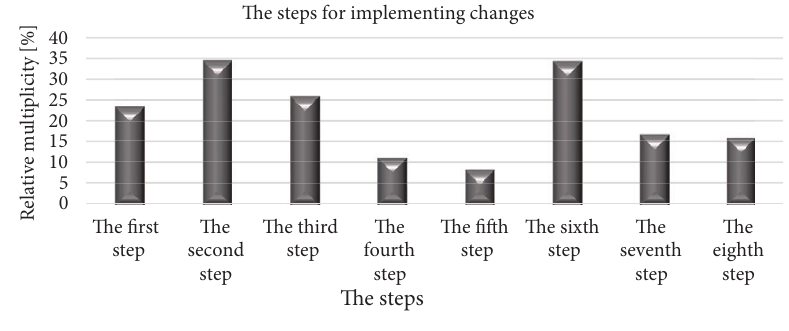
Figure 5. The steps for implementing changes (source: own